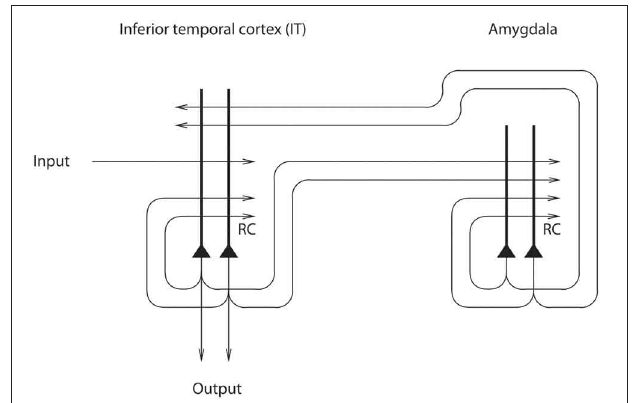
FIGURE 8 | Architecture used to investigate how mood can affect perception and memory. The IT module represents brain areas such as the inferior temporal cortex involved in perception and hippocampus-related cortical areas that have forward connections to regions such as the amygdala and orbitofrontal cortex involved in mood and emotion (after Rolls and Stringer,